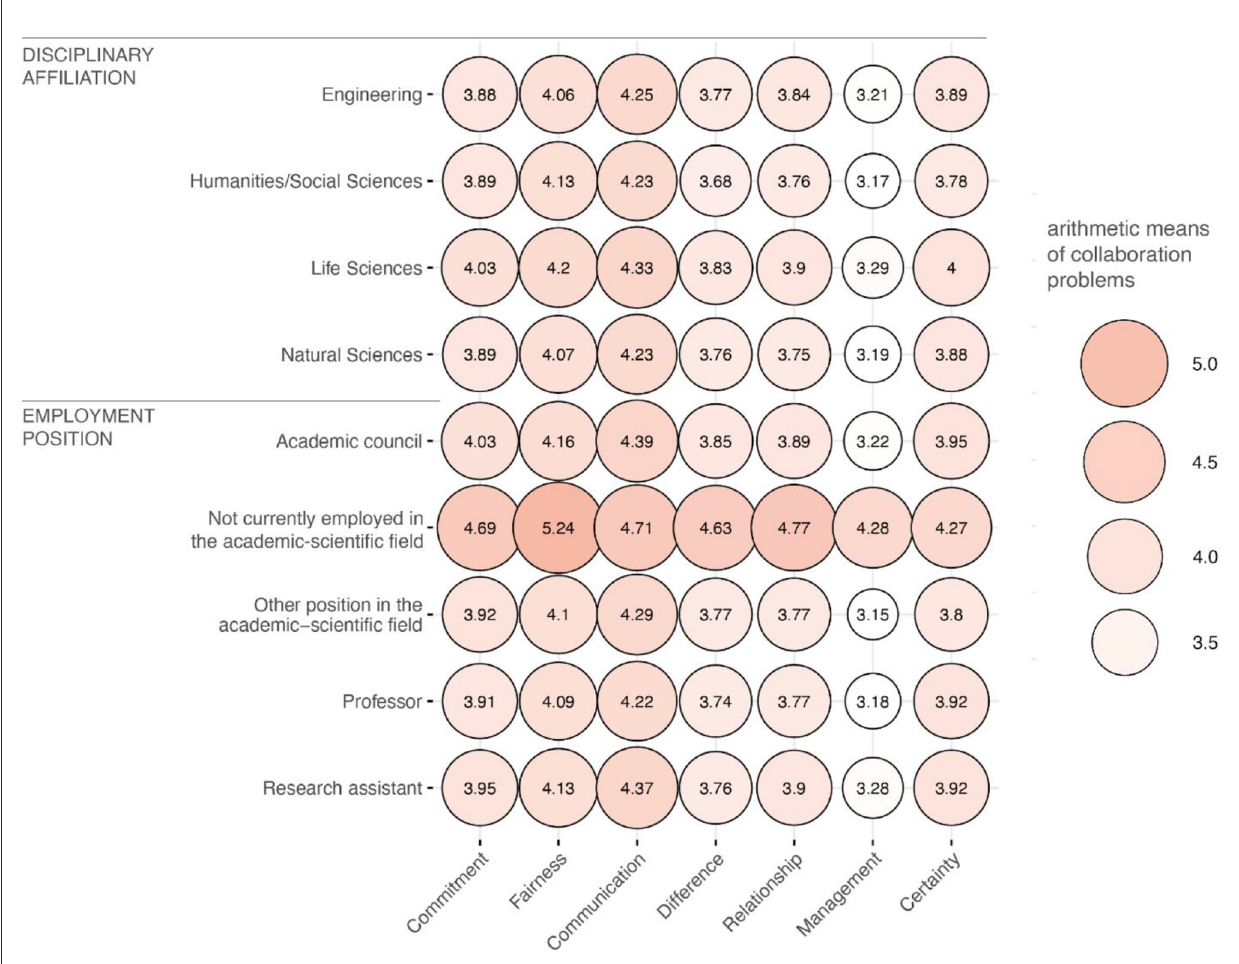
FIGURE3 Perceived relevance of the seven collaboration problems differentiated by individual characteristics of researchers. The higher the arithmetic mean values of the cumulative indices, the redder and larger the respective balloon. The graph is based on the survey data of n = 3,050 PIs and spokespersons after listwise